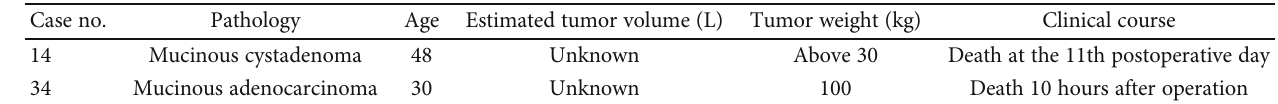
(b) Cases of fatal surgical